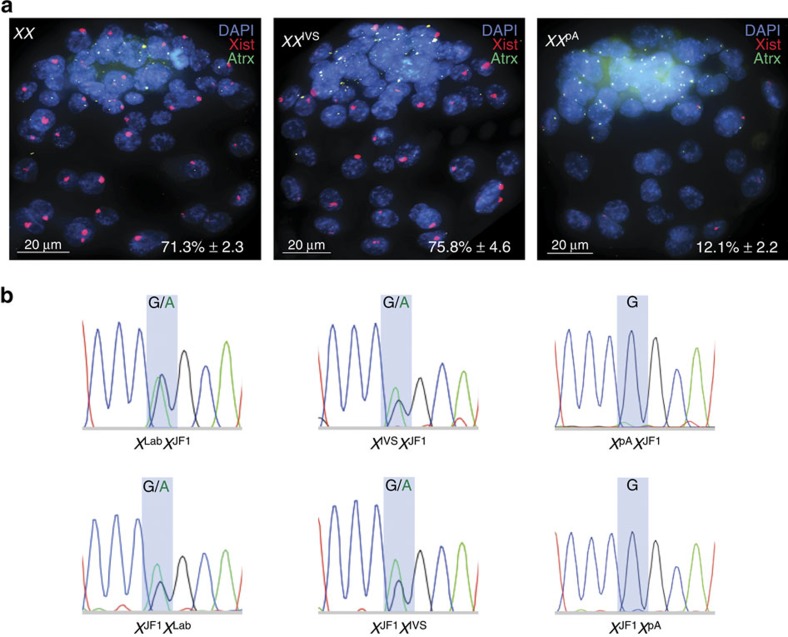
Profiling of Xist RNA coating in XXLab, XXIVS and XXpA embryos.(a) RNA FISH detection of Xist RNA coating in XXLab, XXIVS and XXpA blastocysts. Red, XistAR RNA; green, Xist RNA; white, Atrx; blue, nucleus. Atrx RNA marks the active X chromosome. Numerical values in the images indicate the percentage of nuclei that display Xist RNA coats; ±, s.d. n=3 embryos per genotype. XXpA embryos display significantly fewer nuclei with Xist RNA coating compared with both XXIVS (P<10−3; Welch's two-sample t-test) and XXLab (P<10−4). (b) Sanger sequencing chromatograms of Xist cDNAs in F1 hybrid XJF1XLab, XJF1XIVS and XJF1XpA E6.5 epiblasts (top). Similar analysis was performed with embryonic epiblasts from the reciprocal cross of these genotypes (bottom). In XJF1XpA and XpAXJF1 epiblasts, Xist is expressed exclusively from the XJF1X chromosome.